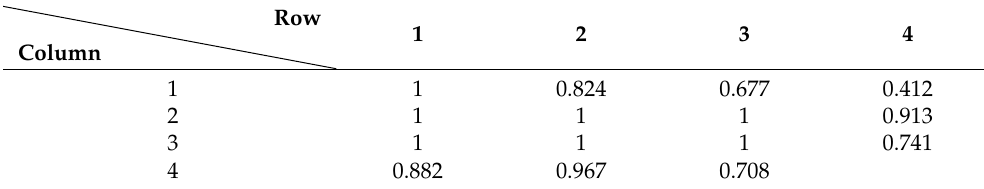
Table 1. Area normalization scale factors of different wing blocks.